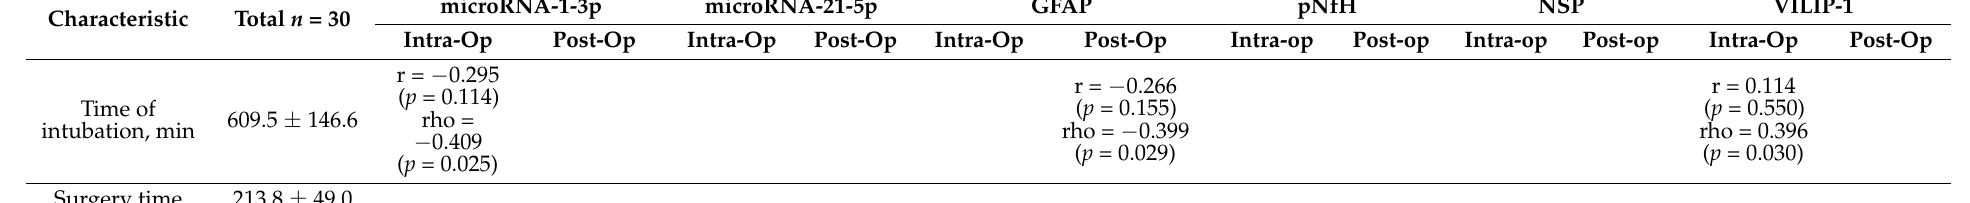
Table 2. Associations of candidate biomarkers’ intra- and postoperative expression changes with perioperative